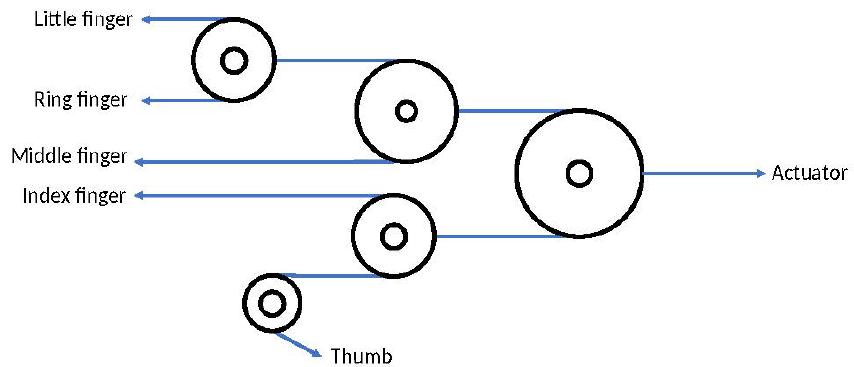
Figure 6. "Federica"’s whippletree mechanism using a multiple-pulley system [20].